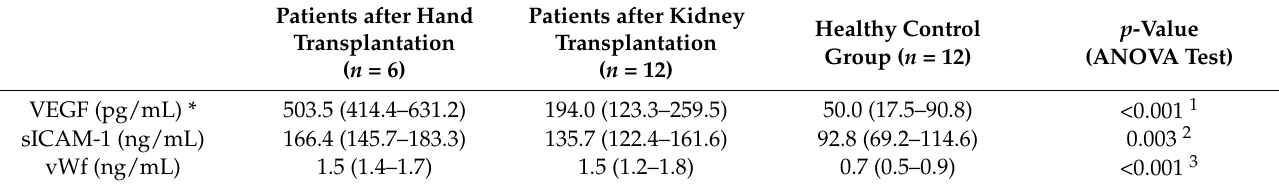
Table 2. Markers of endothelial activation in study